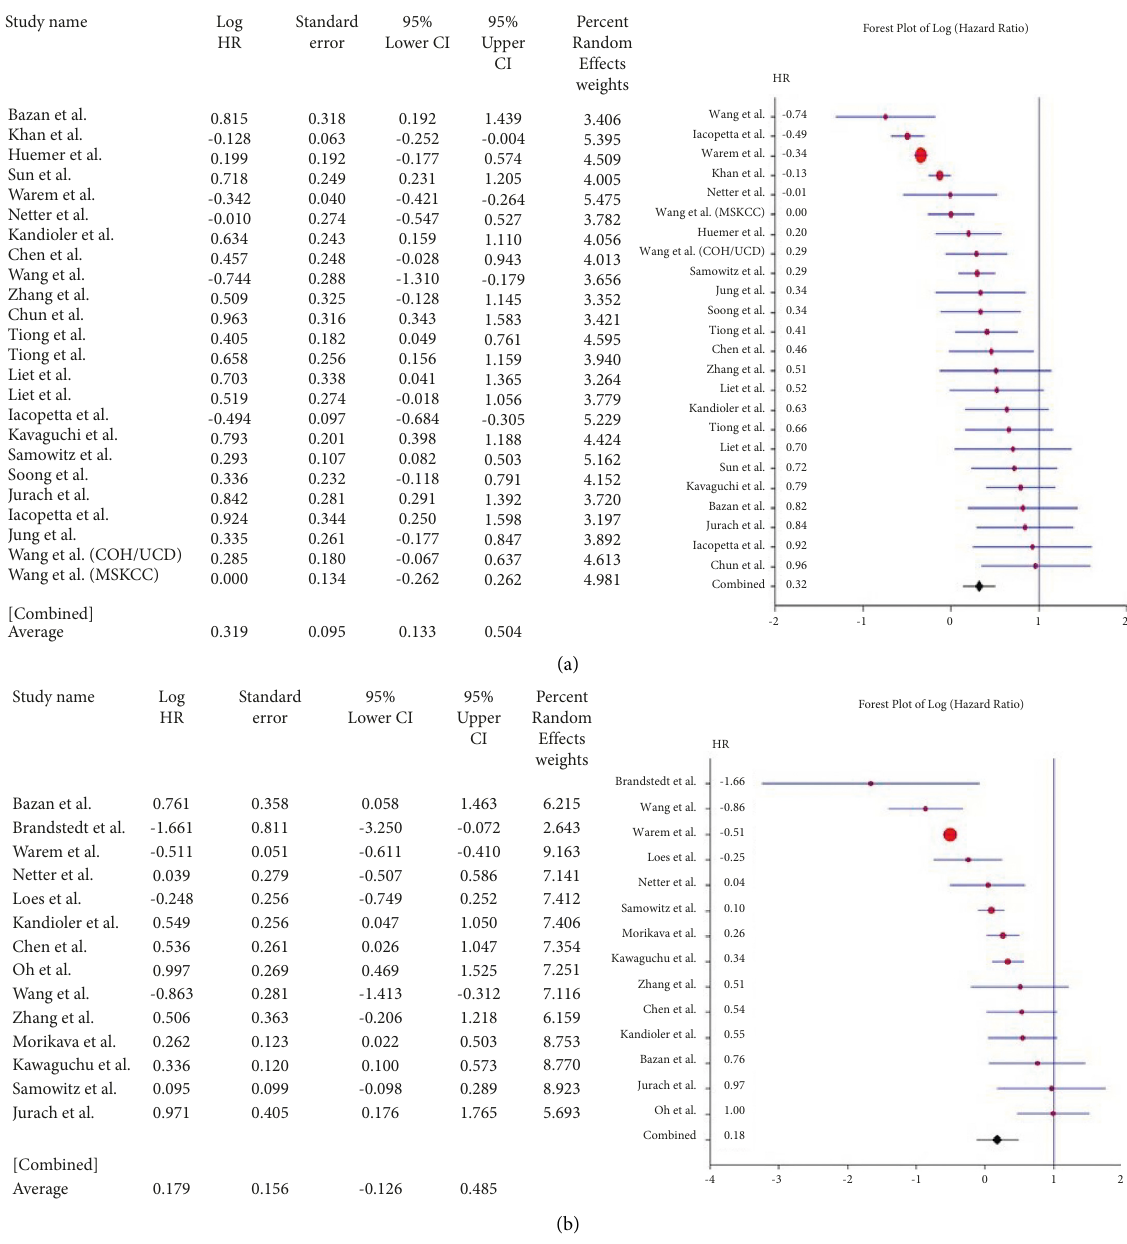
Figure 5: Forest plot of TP53 gene and overall survival in CRC (a). Forest plot of TP53 gene and disease-free survival in CRC